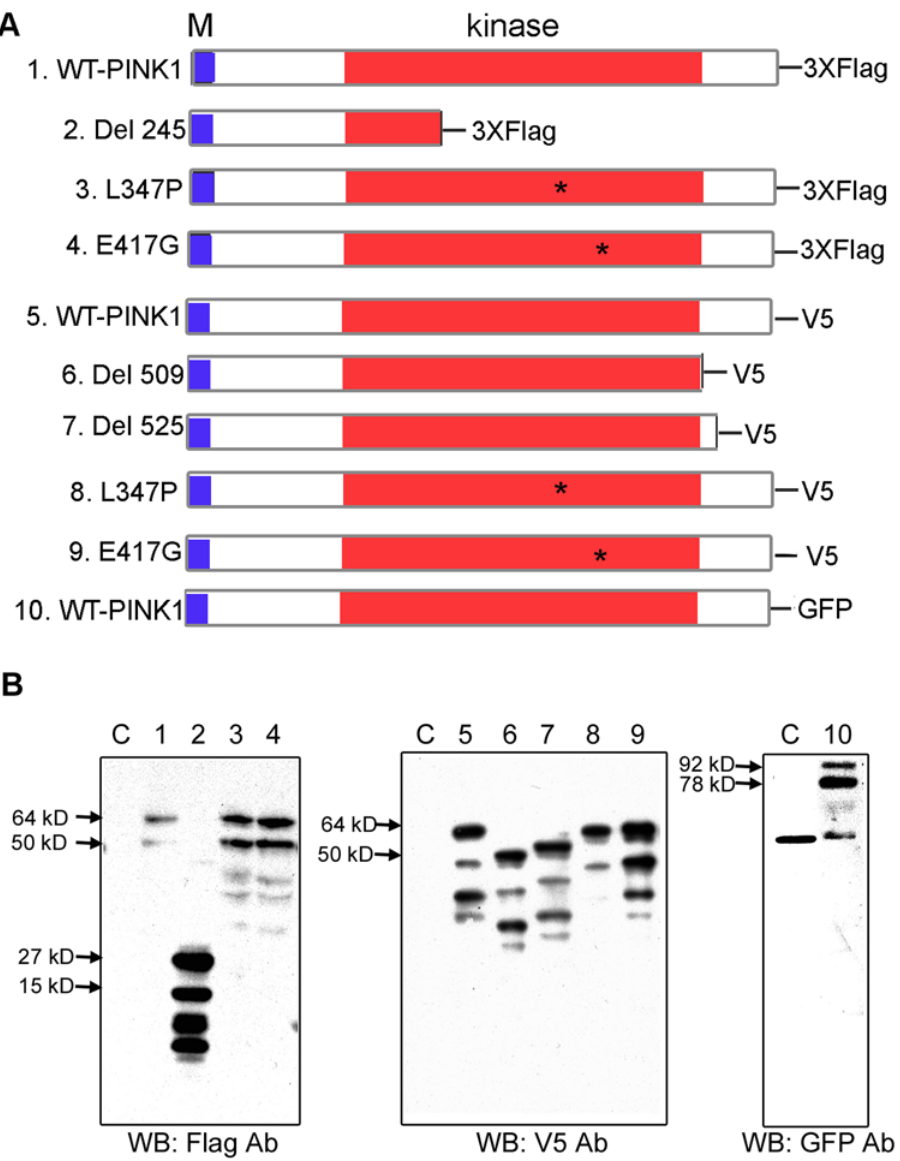
Figure 1. PINK1 constructs and their expressions. A) A schematic depiction of PINK1 constructs. Full length wild type, L347P-, or E417G- PINK1 tagged with Flag, V5, or GFP are indicated. Several truncated PINK1 tagged with Flag or V5 are also depicted. M stands for mitochondrial targeting sequence. B) Confirmation of the expression of the above constructs in HEK 293 cells. HEK293 cells were transfected by various PINK1 constructs, and their lysates were analyzed by Western blots with Flag antibody (Left panel), V5 antibody (the middle panel) or GFP antibody (the right Panel). Lane 1–10 are lysates from cells transfected by plasmids with the same numbering as shown in A) . The lysates from the cells transfected with the empty cloning vector without PINK1 insert were used as controls (labeled as C). The results demonstrated that the expression of all constructs yielded recombinant PINK1 proteins with expected molecular weights.